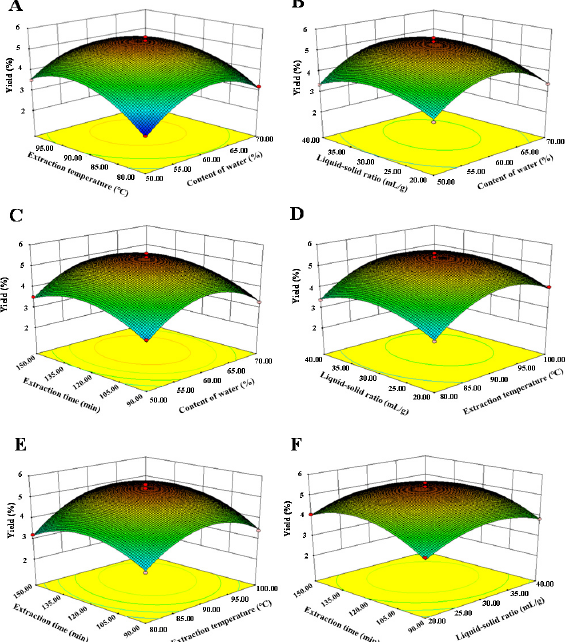
Figure 2. Three-dimensional response surface plots of deep eutectic solvent assisted extraction. ( A ) interaction between content of water and extraction temperature; ( B ) interaction between content of water and liquid-solid ratio; ( C ) interaction between content of water and extraction time; ( D ) interaction between liquid-solid ratio and extraction temperature; ( E ) interaction between extraction time and extraction temperature; ( F ) interaction between extraction time and liquid-solid ratio.